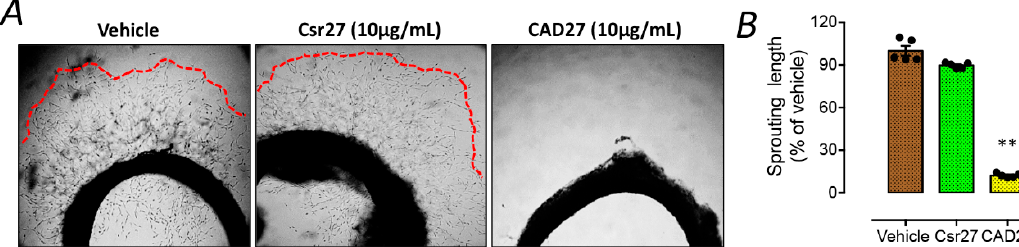
Figure 3. The effect of CAD27 on vascular sprouting from rat aortic ring explants. ( A ) Representative images and ( B ) quantitative analysis of vascular sprouting in 3 week-old rat aortic ring explants. Data are presented as the mean ± SEM ( n = 5). Statistical analysis between groups was performed using one-way ANOVA followed by Tukey’s multiple comparisons test (** p < 0.001). Red lines indicated the border zone of vascular sprouting.